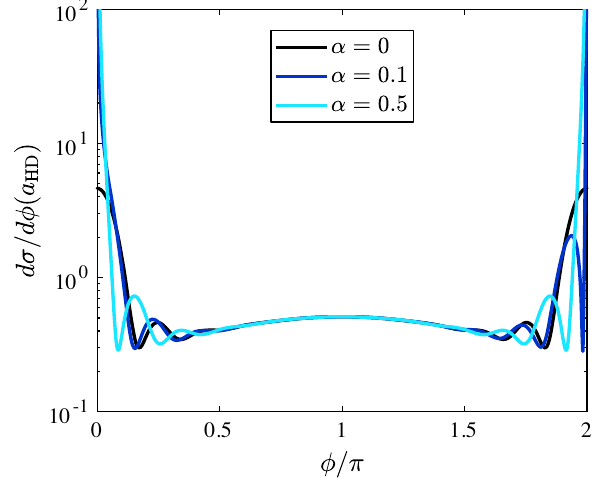
FIG. 10. Differential scattering cross section d σ =d ϕ in units of the hard-core radius a as a function of the scattering angle ϕ for HD a hard-disk interaction potential V between distinguishable ii 5 , and impurities with a relative incident momentum ka HD ¼ for three values of the statistical parameter α